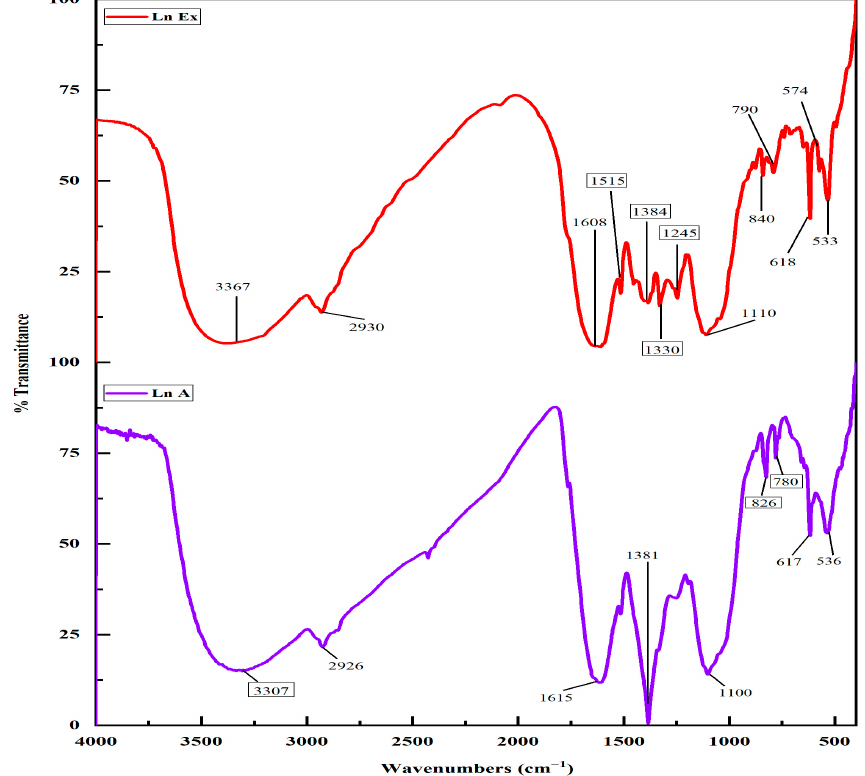
Figure 4. FTIR spectrum of flower bud extract and biosynthesized LnFb-AgNPs.